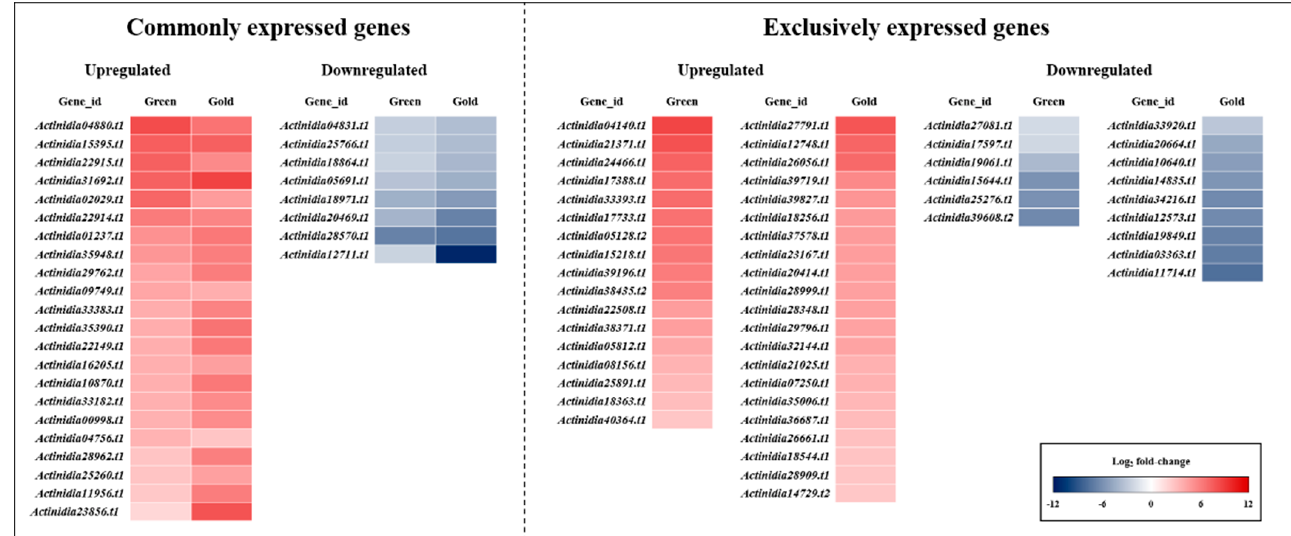
Figure 5. Heat map of commonly and exclusively expressed and identified DEGs related to softening- and ripening-related changes in the comparison of control vs. ethylene-treated green ‘Hayward’ and gold ‘Haegeum’ kiwifruit on the third day of ripening.